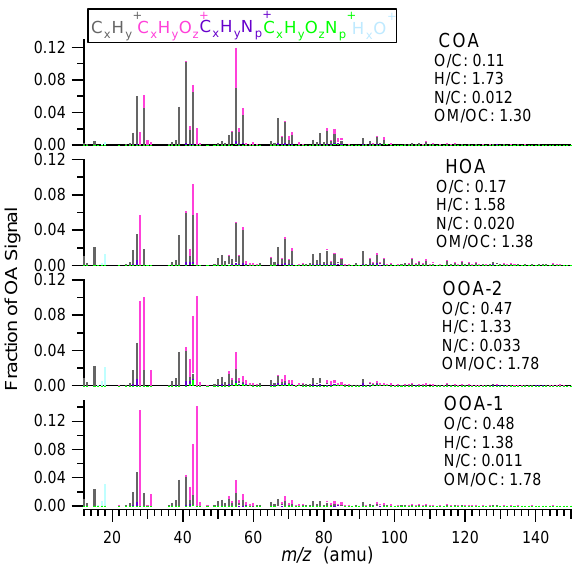
Fig. 3. The MS profiles of the four OA components of this study identified by PMF.